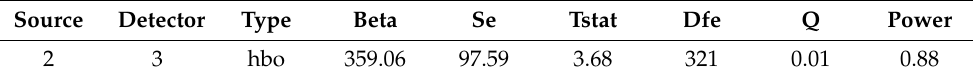
Table A9. t -test statistics for each channel (source–detector pair). Lotus Uplifting–Lotus.